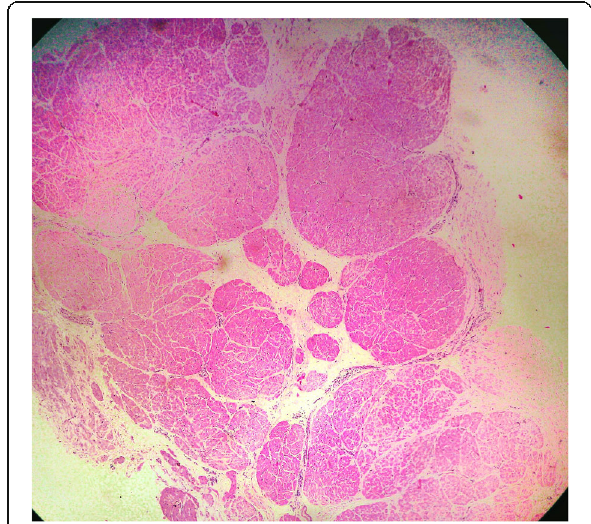
Fig. 3 Histopathological Hand E stain of the ISB showing smooth muscle bundles